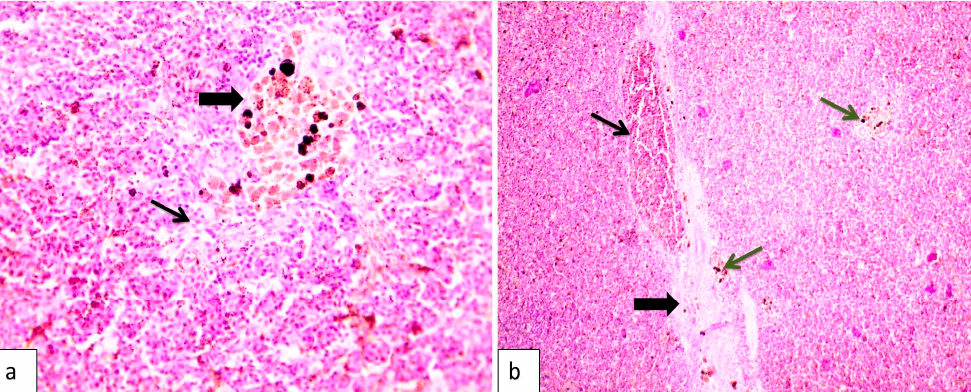
Figure 2. Histopathological lesions in spleen of naturally diseased Nile tilapia showing ( a ) Activation of melanomacrophages (thick arrow) with lymphocytic depletion (arrow), H&E, 400×. ( b ) Congested blood vessels (thin arrow) with edema widely separated splenic cells (thick arrow) and hemosiderosis (green arrows), H&E, 100×.